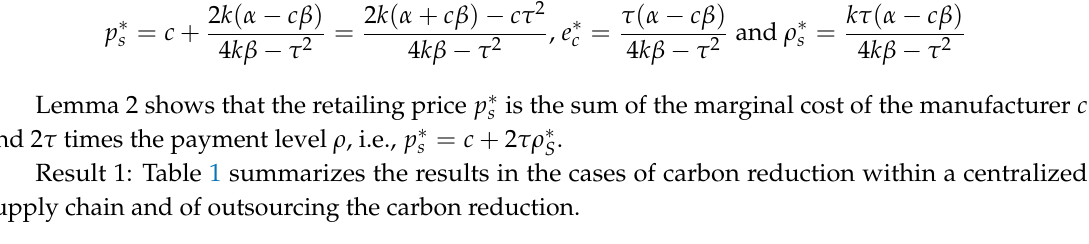
Table 1. Results for a case of carbon reduction within a centralized supply chain and the case of outsourcing the carbon